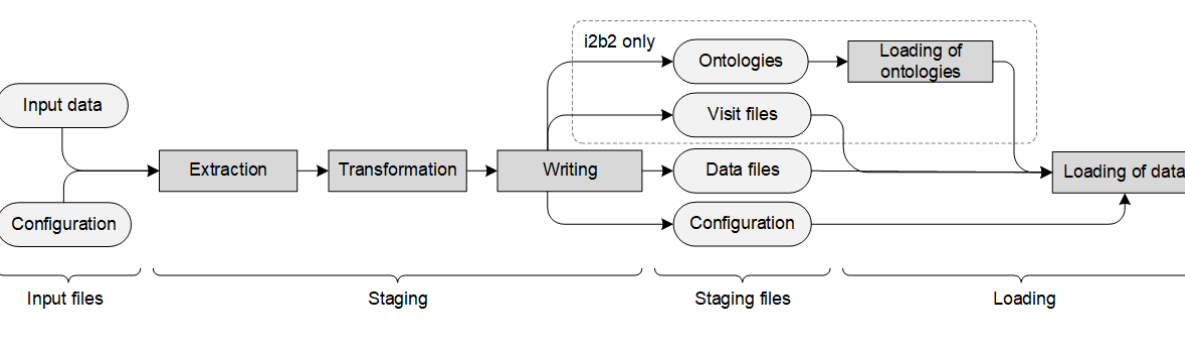
Figure 3. Overview of data staging and loading with the tool developed. i2b2: Informatics for Integrating Biology and the